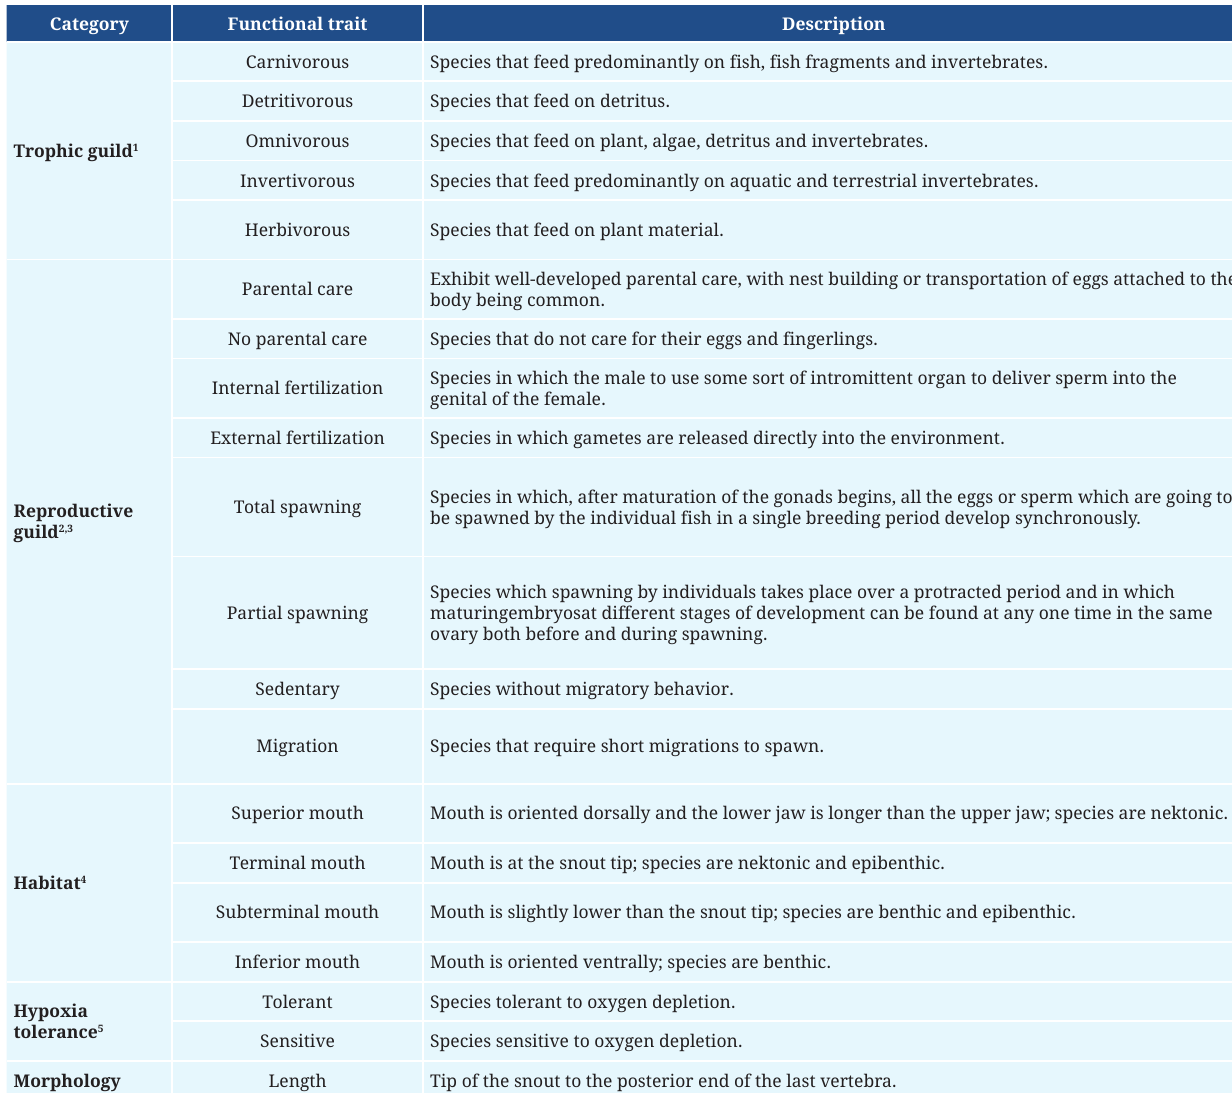
TABLE 1 | Description of functional traits obtained for fish species sampled in the 24 streams in the state of Paraná, Brazil. ( 1 Mazzoni et al ., 2010; Nimet et al ., 2015). A same species can present more than one trait of this guild according to its feeding; 2 Vazzoler, 1996; 3 Agostinho, Júlio-Jr., 1999; 4 Mazzoni et al ., 2010; 5 Teresa, Casatti, 2012). Category Description